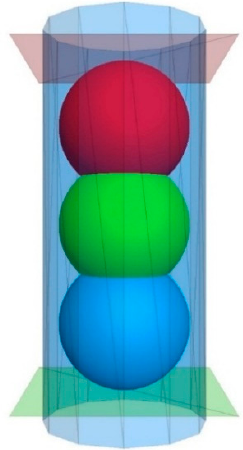
Figure 8. Position of the measurement region in the container.